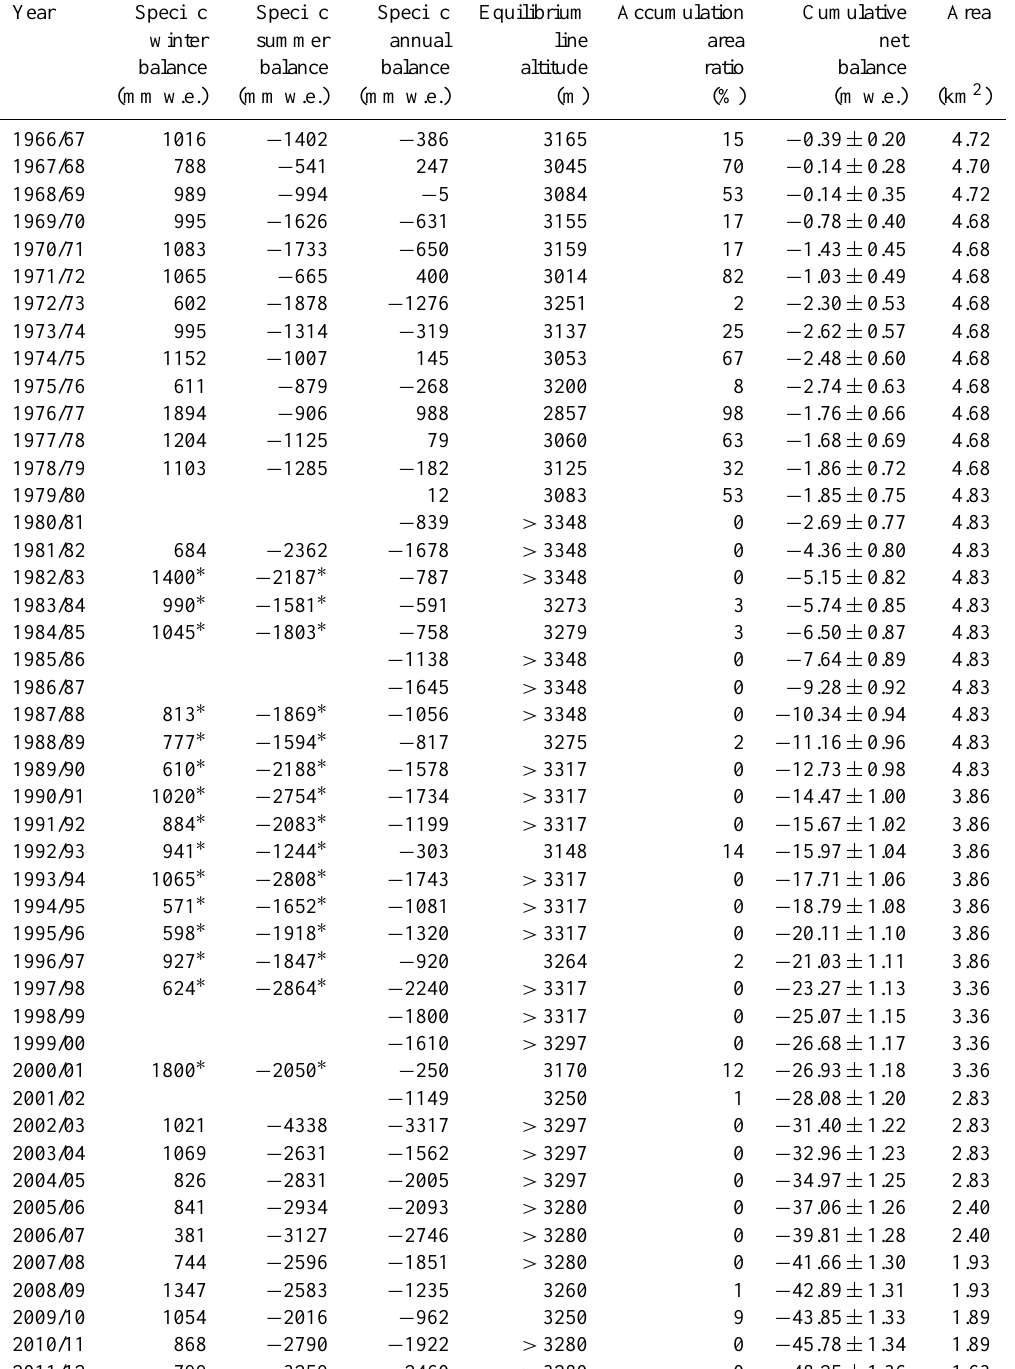
Table 3. Careser Glacier mass balance series from 1967 to 2012. Values with asterisks are “index” values (i.e. measurements on few repre- sentative points close to the median elevation of the